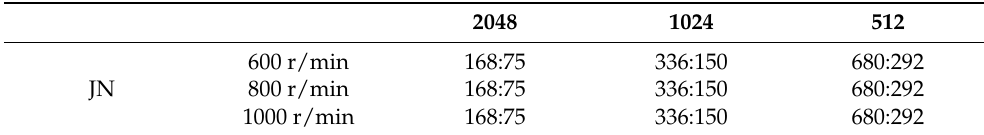
Table 1. Dataset specific